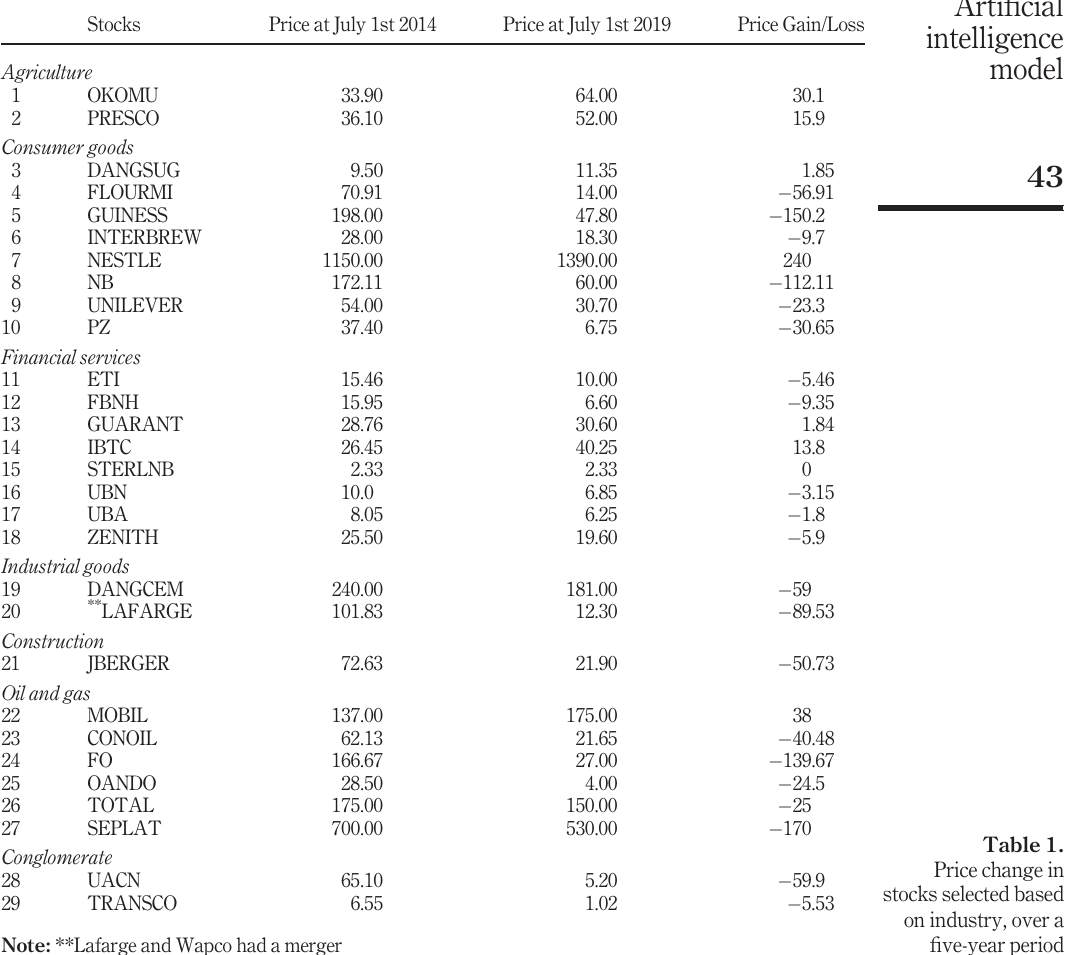
Table 1. Price change in stocks selected